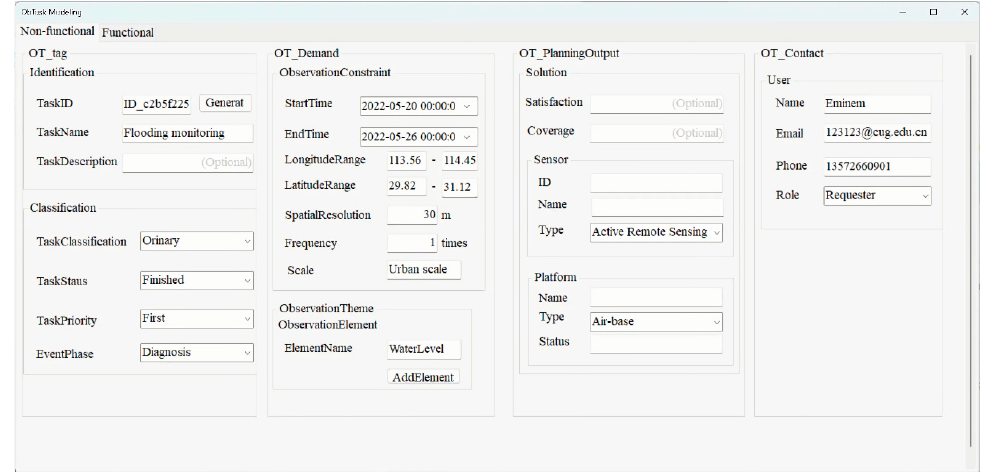
Figure 8. Interface of earth observation task modeling.